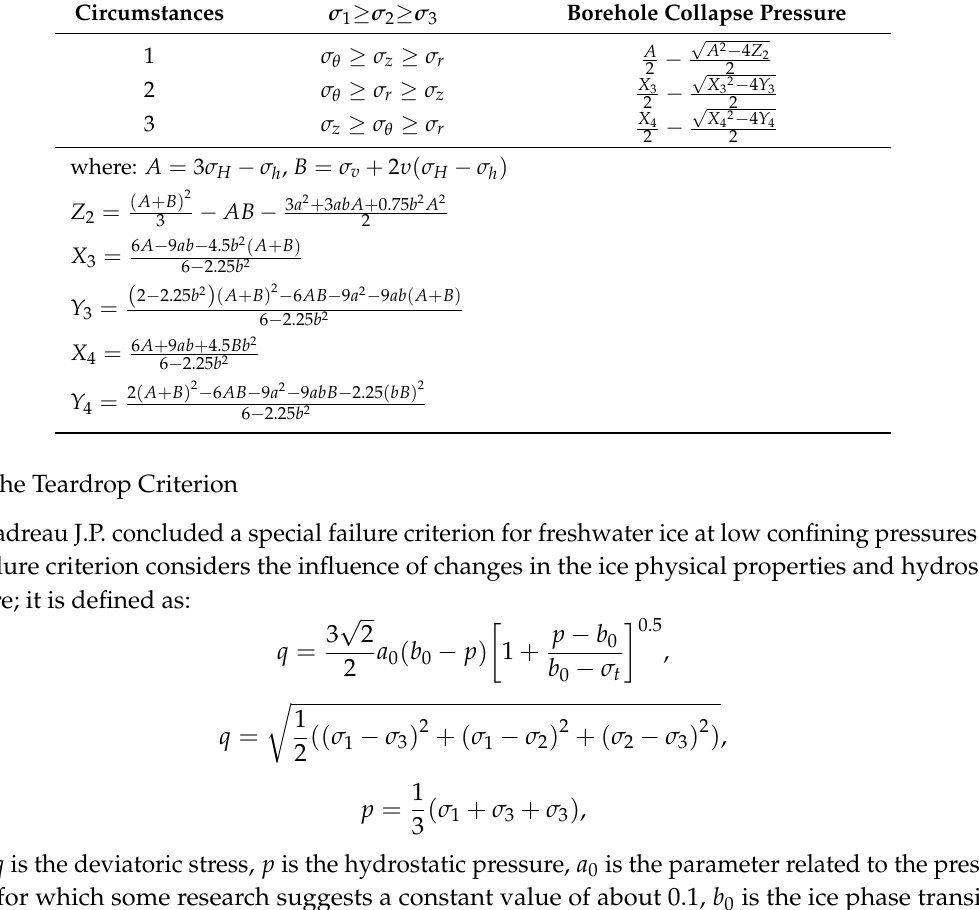
Table 2. Mogi–Coulomb criterion for the determination of the collapse pressure in an ice borehole. Circumstances σ 1 ≥ σ 2 ≥ σ